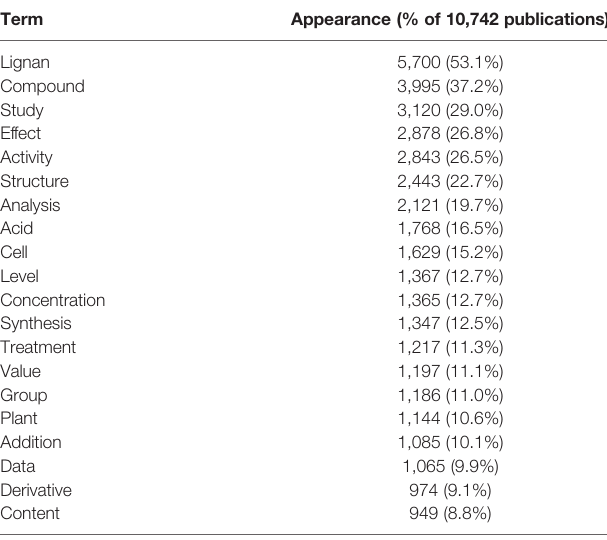
TABLE 3 | The top 20 recurring terms from titles and abstracts.